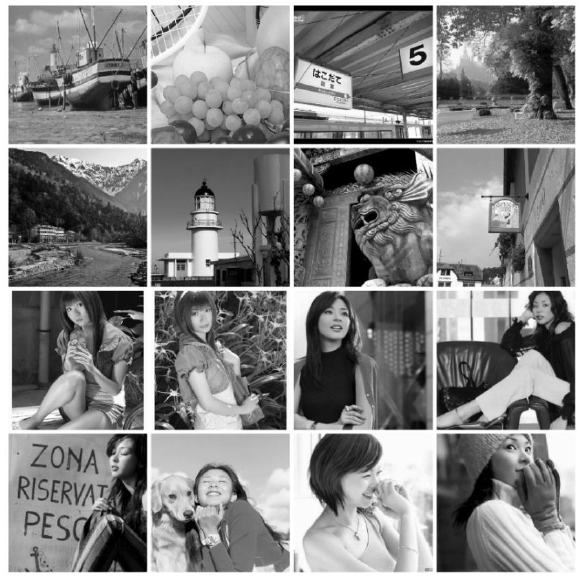
Figure 9. A set of images, named as Image Set 1, used to validate proposed method performance.